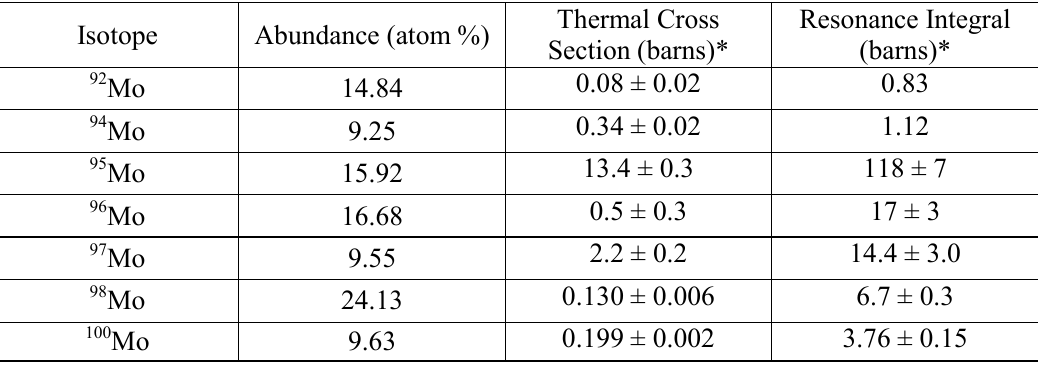
Table III. Abundances of molybdenum isotopes and associated thermal cross sections and resonance integrals . Thermal Cross Resonance Integral Isotope Abundance (atom %) Section (barns)*